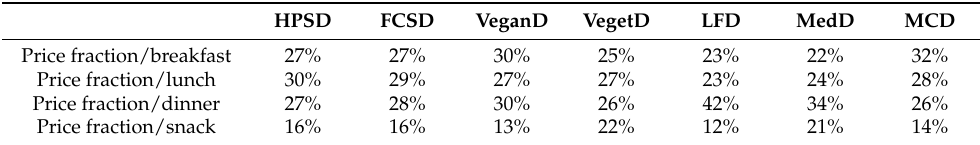
Table 5. Percentage of food prices according to meal time.